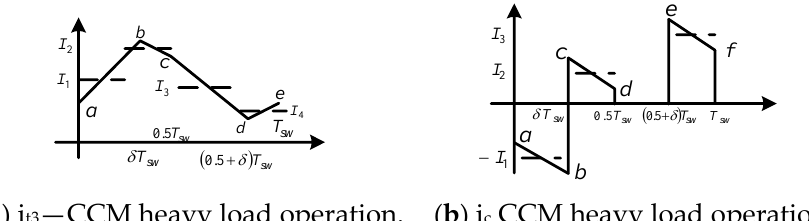
Figure 16. Various current waveforms for converter 2-3.1 . Table 3. Analytical and simulated date for converter 2-3.1 under CCM . From (30)–(35) and Table 3, it is seen that expressions in (24) yield accurate signal averages and RMS values as well as signals’ ripple RMS values. The good agreement Analytical values for DC – DC converter 2-3.1 signal i t1 between analytical and simulated values validates the accuracy of the analytical techniques that were developed.